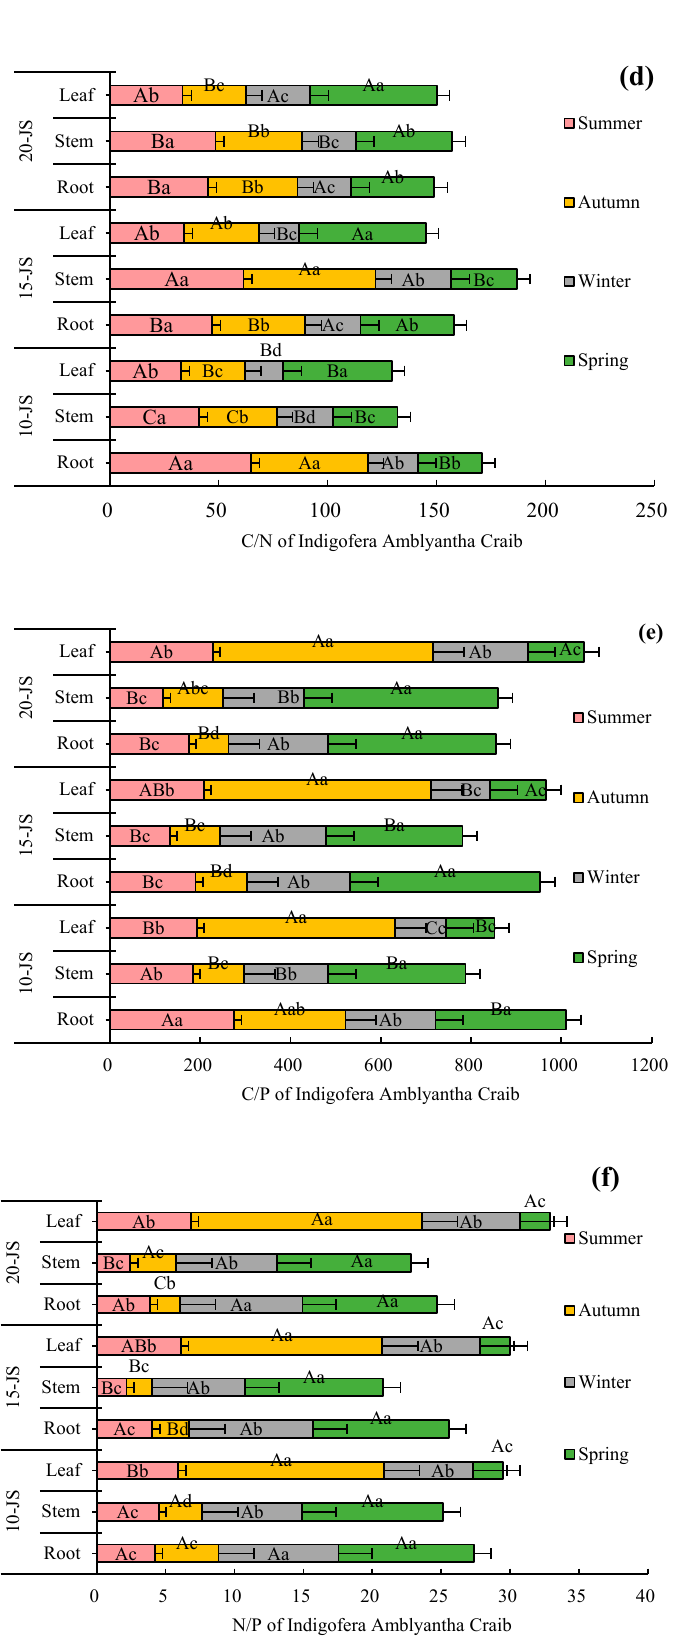
Figure 4. The C/N, C/P and N/P of plants under different precipitation patterns. Note: ( a ) C/N of the Cynodon, ( b ) C/P of the Cynodon, ( c ) N/P of the Cynodon, ( d ) C/N of the Indigofera Amblyan- tha Craib, ( e ) C/P of the Indigofera Amblyantha Craib, ( f ) N/P of the Indigofera Amblyantha